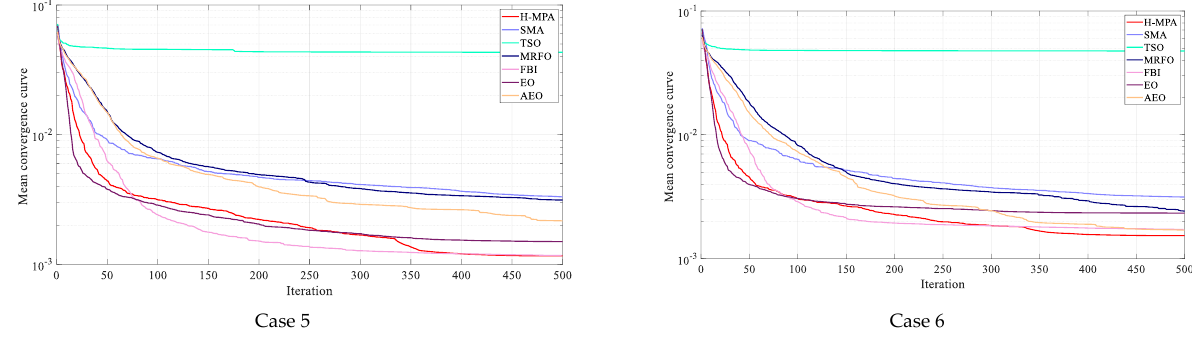
Figure 7. The mean convergence curve by the proposed H-MPA, and the other counterparts for the implemented cases.